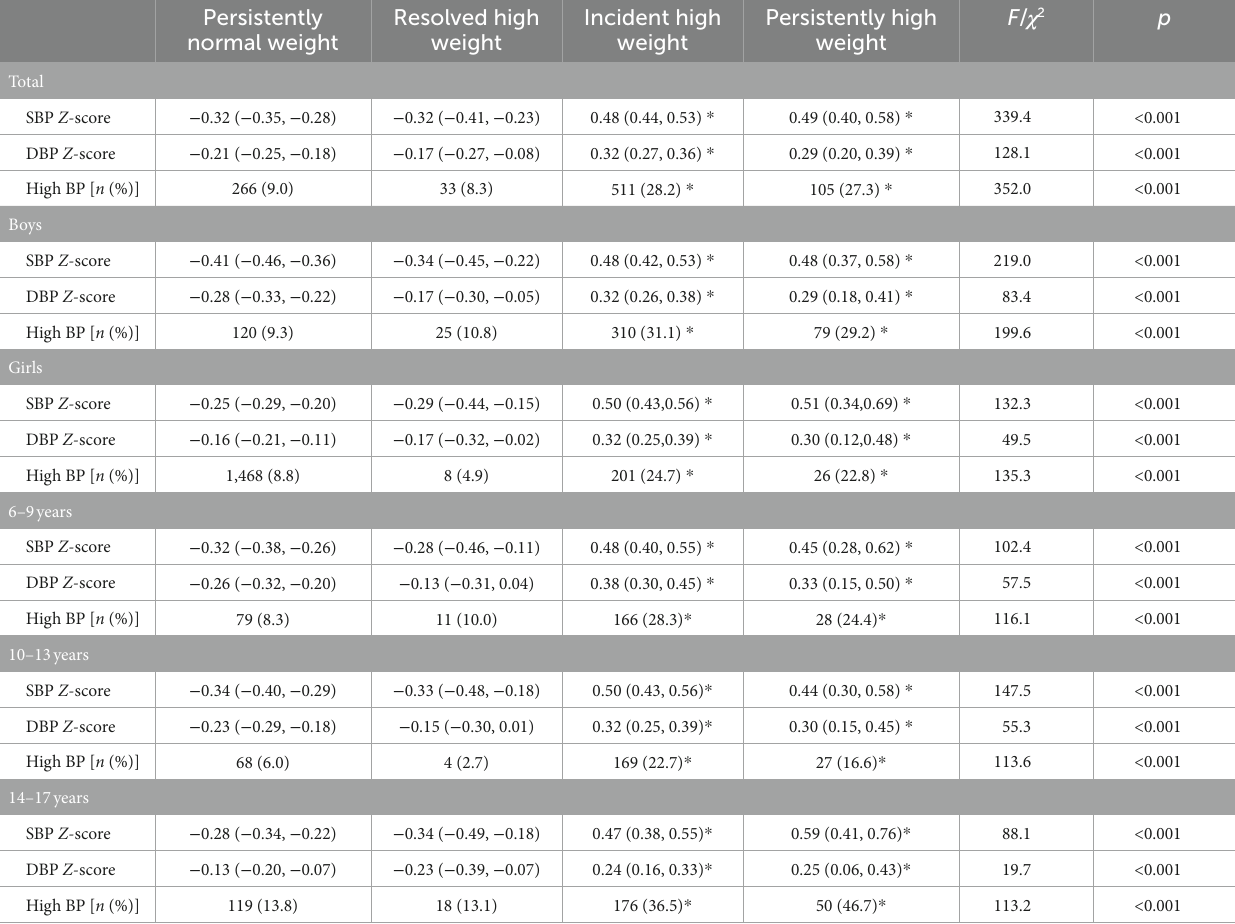
TABLE 3 Comparison of blood pressure levels and prevalence of high BP among different weight status change groups. Persistently Resolved high Incident high Persistently high normal weight weight weight weight